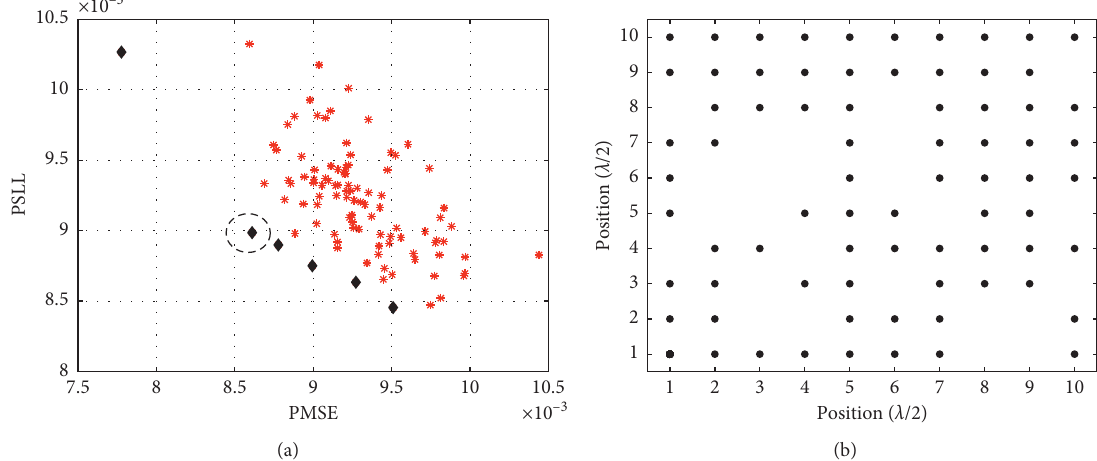
Figure 9: Pareto fronts produced by MODE. (a) Pareto fronts. (b) Position of antenna.